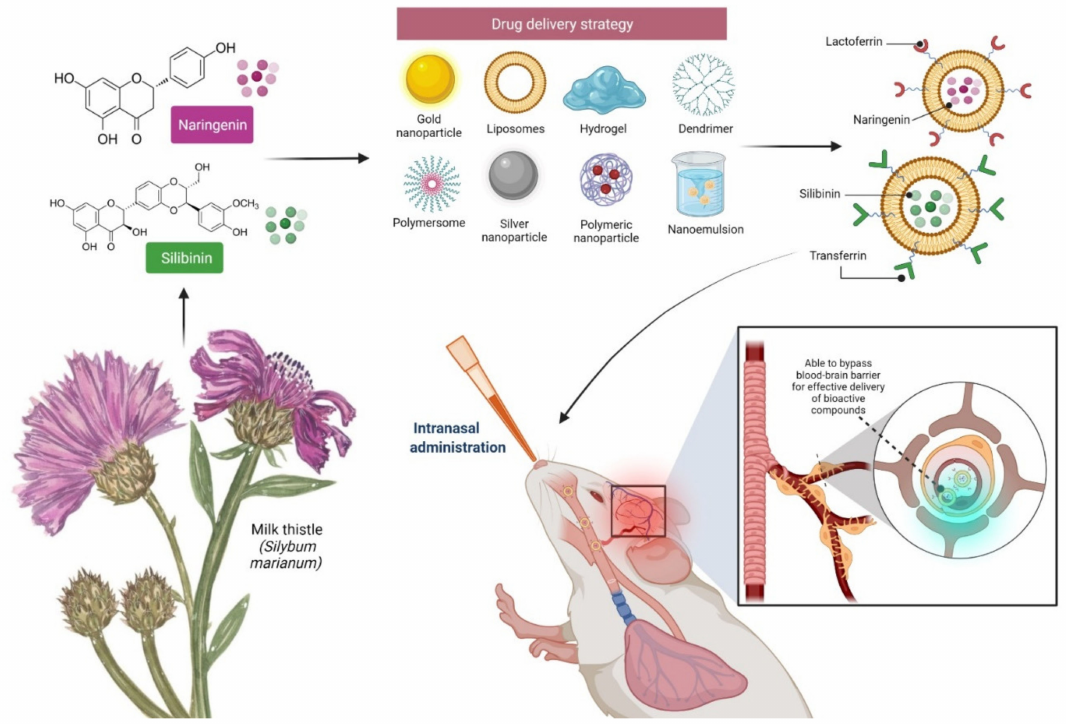
Figure 7. Drug delivery strategy of silibinin and naringenin through the intranasal route.